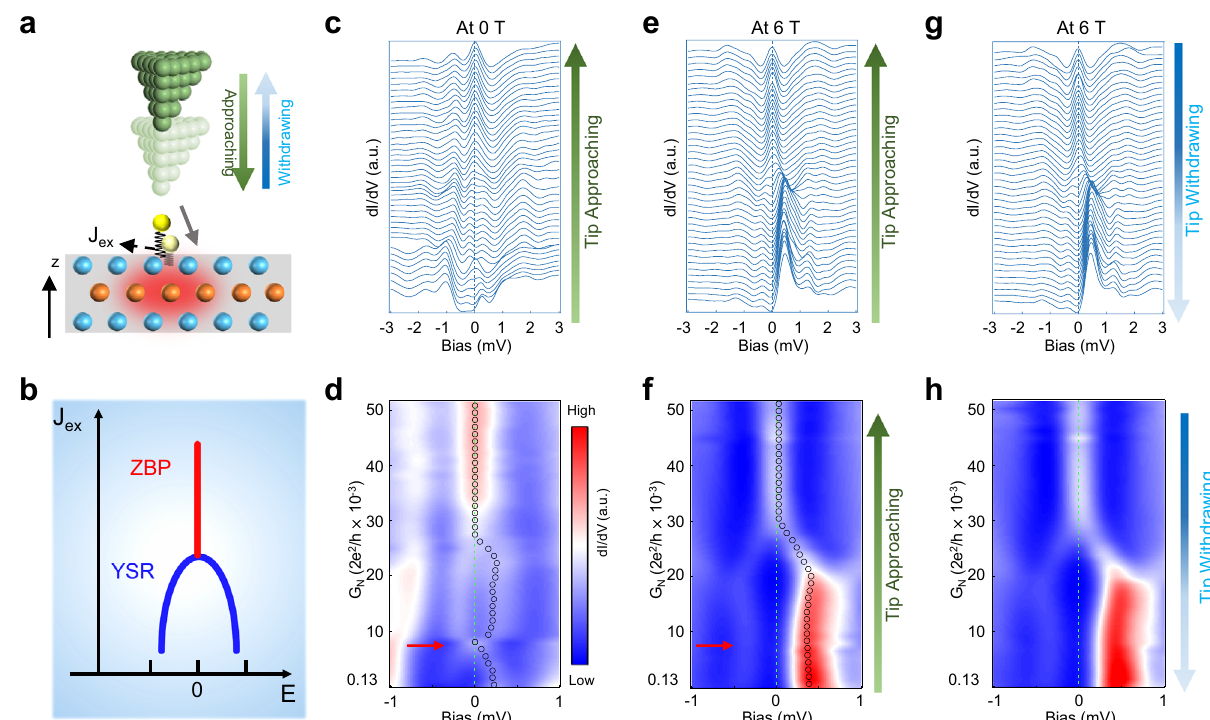
Fig. 3 Reversible transitions between YSR states and a robust ZBP/MZM induced by modulating the exchange coupling of type-II Fe adatoms using the STM tip. a Schematics illustrating an approaching STM tip on top of a type-II Fe adatom can move the Fe adatom in directions parallel and perpendicular to the Te/Se surface and modulate the spin – orbit exchange coupling ( J ex ) to the superconductor. b Schematic phase diagram from the vortex-free YSR states to an anomalous vortex MZM represented by the ZBP with the increasing exchange coupling J ex . c and d Tunnel-barrier conductance dependence of the d I /d V spectra in c and its intensity plots in d , showing the evolution of vortex-free YSR states into a robust ZBP at 0 T under an approaching-tip. Red arrow in d indicates the position of an accidental near degeneracy of the YSR states. Black circles in d trace the peak positions. e and f are the same as c and d , but measured in a magnetic fi eld of 6 T. Black circles in f trace the peak positions. The accidental degeneracy of the YSR states in 0 T in d is removed by the 6 T magnetic fi eld, while the evolution to the ZBP remains robust. g and h are the same as e and f , but showing the transition from ZBP to YSR states by withdrawing the STM tip at 6 T, indicating the transition is